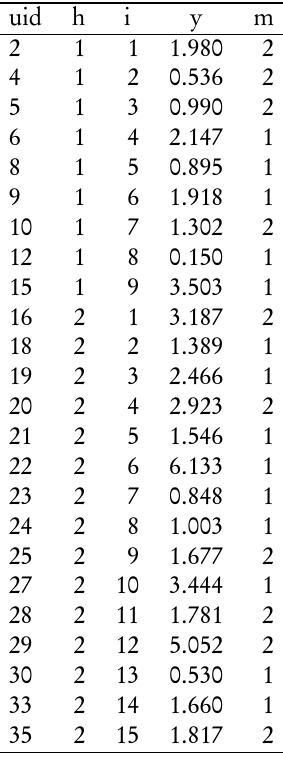
Second frame extracted from the toy